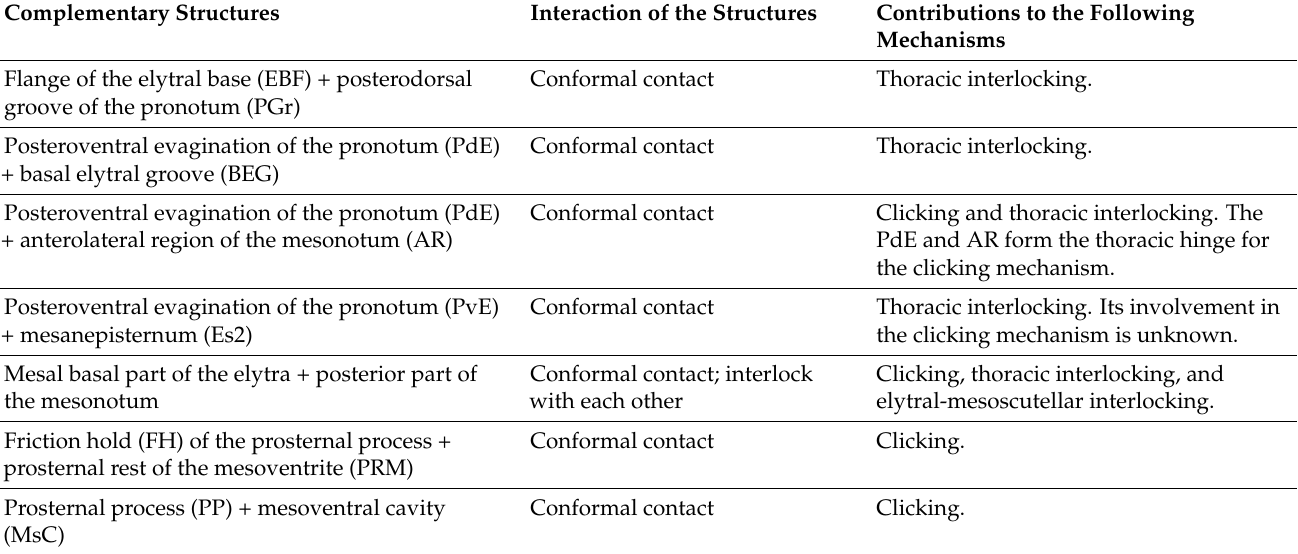
Table 4. The complementary structures of the pro- and mesothorax of Campsosternus auratus